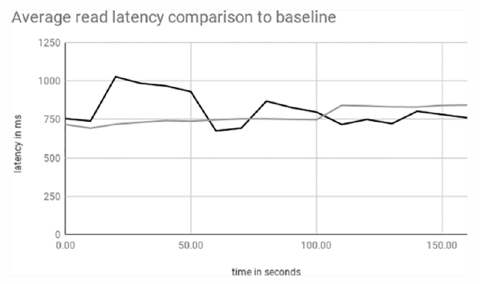
Figure 22. Average read latency of twice scaled cluster versus the baseline, single shard cluster.